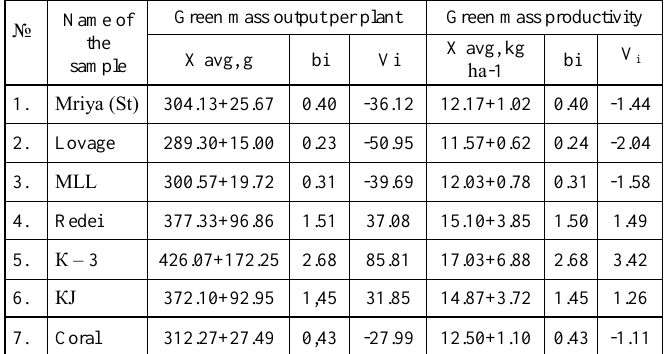
( Figure 6 ). Determination coefficient is insufficient (R 2 =0.30), and the coefficient of the multiple correlation is medium (R=0.55), which shows the average percentage of possibility of the use of the given equation for the definition of the productivity level. Selection plays an important role in the increase of the lovage seed productivity. The success of obtaining positive results depends on the correctly chosen source material and creation of new, hopefully highly productive varieties on its